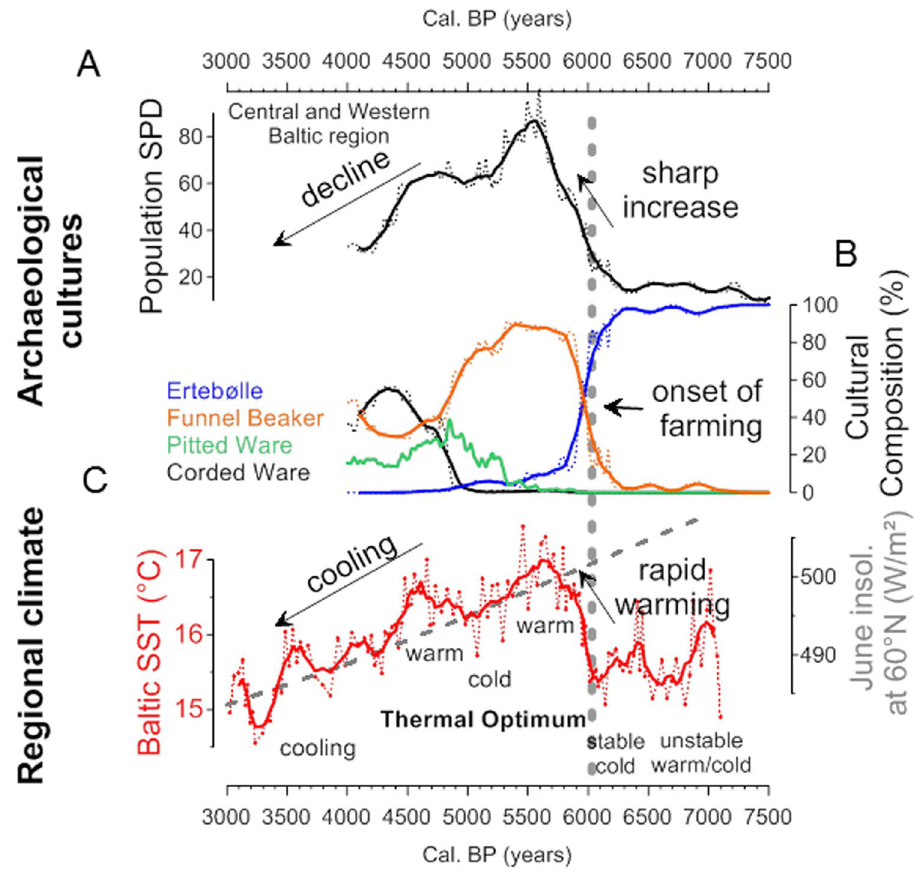
Figure 4. Mid-Holocene SPD records from the Baltic Region in relation to climatic changes. ( A ) Population proxy using a summed probability distribution (SPD) of archaeological radiocarbon dates within the polygon indicated in Fig. 1. Y-axis represents the probability density, on a relative scale. ( B ) Cultural composition (%) based on the subset of the radiocarbon dates with cultural affiliations assigned by the original excavator (58% of full dataset used in ( A )). Note the rapid change at the boundary between the Meso- and Neolithic, coincides with a substantial increase of the population. Dotted lines show the complete time series, solid lines show a 200 yr rolling mean, to dissuade overinterpretation of small scale wiggles from the calibration curve. ( C ) Summer SST record based on TEX 86 palaeothermometry. The red line plots the 5-point rolling mean. June insolation at 60°N (in W m − 2 ) is plotted as a grey dashed line. The population levels increased synchronously with a period of warming after 6,000 cal. yr